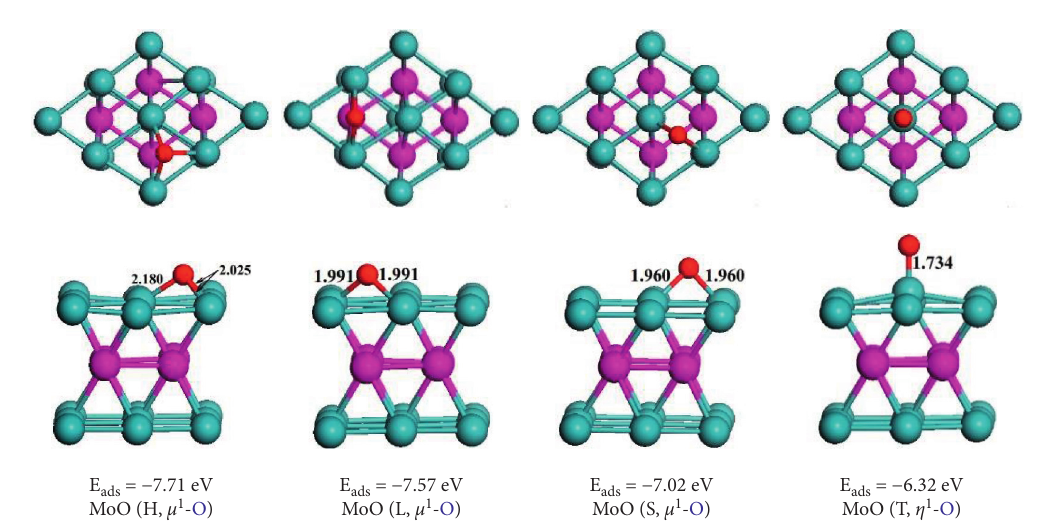
Figure 4: Adsorption structures of O atoms on the Mo (110) surface.